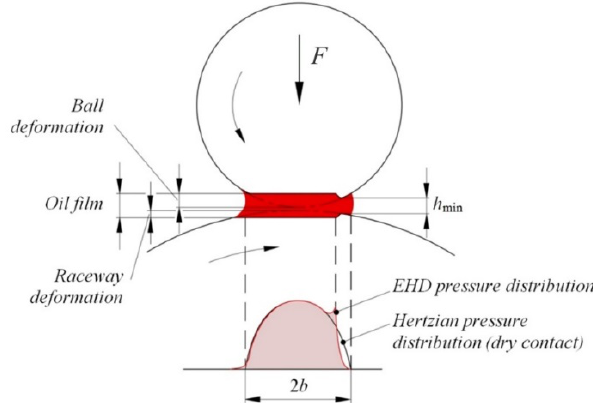
Figure 2. The pressure distribution in the contact zone during EHL